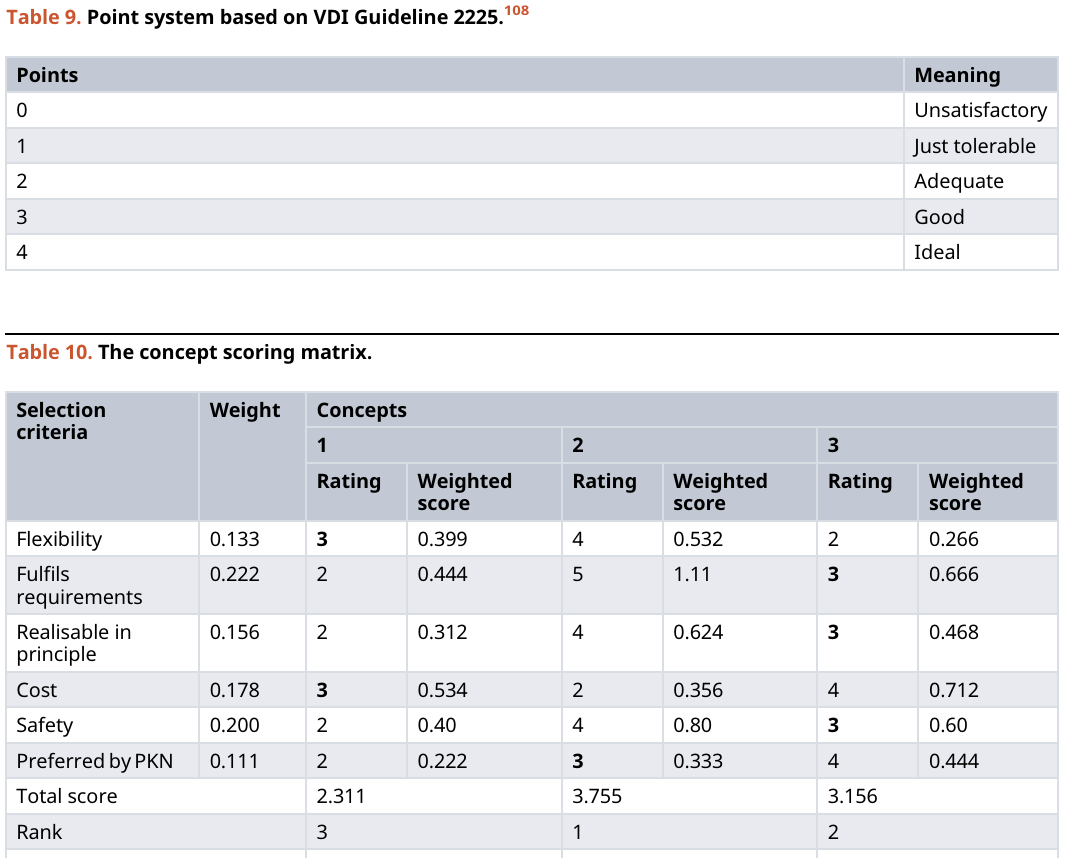
Table 9. Point system based on VDI Guideline 2225. 108